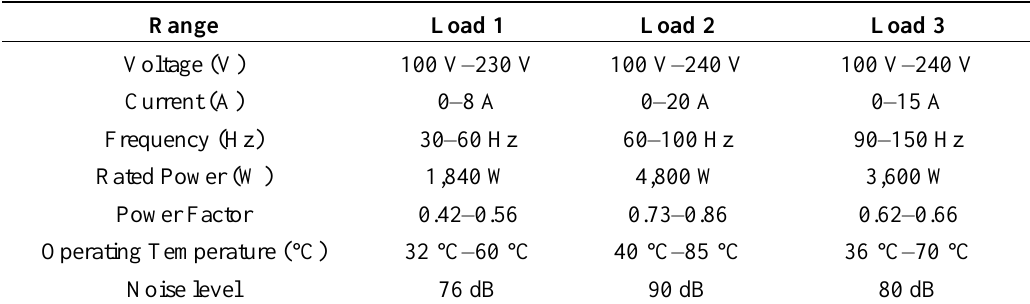
Table 2. Basic specifications for Loads 1, 2 and 3.